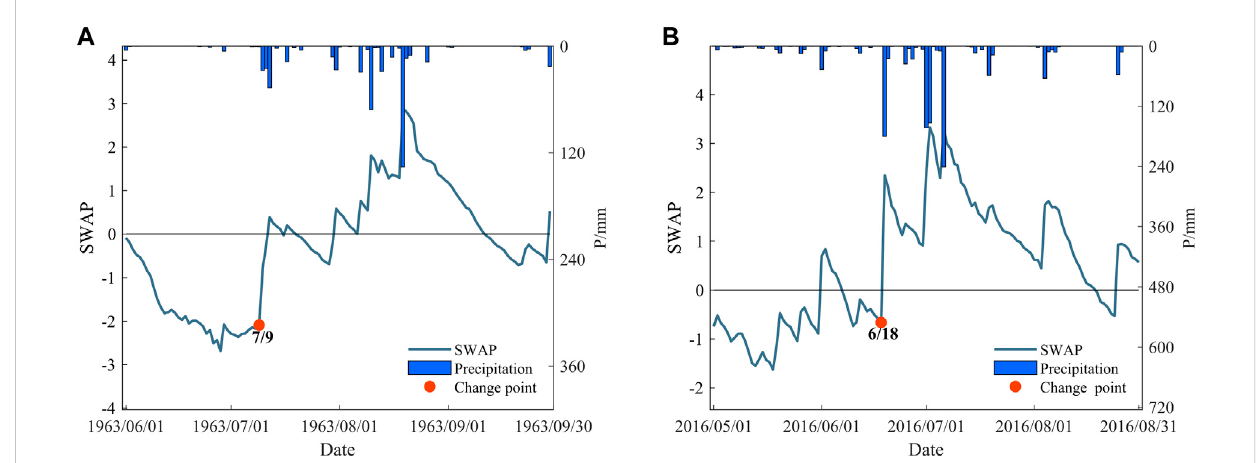
FIGURE 7 Relationships between SWAP and precipitation during the last two events: (A) 1963 and (B) 2016. Change points are identi fi ed by the DWAAI.